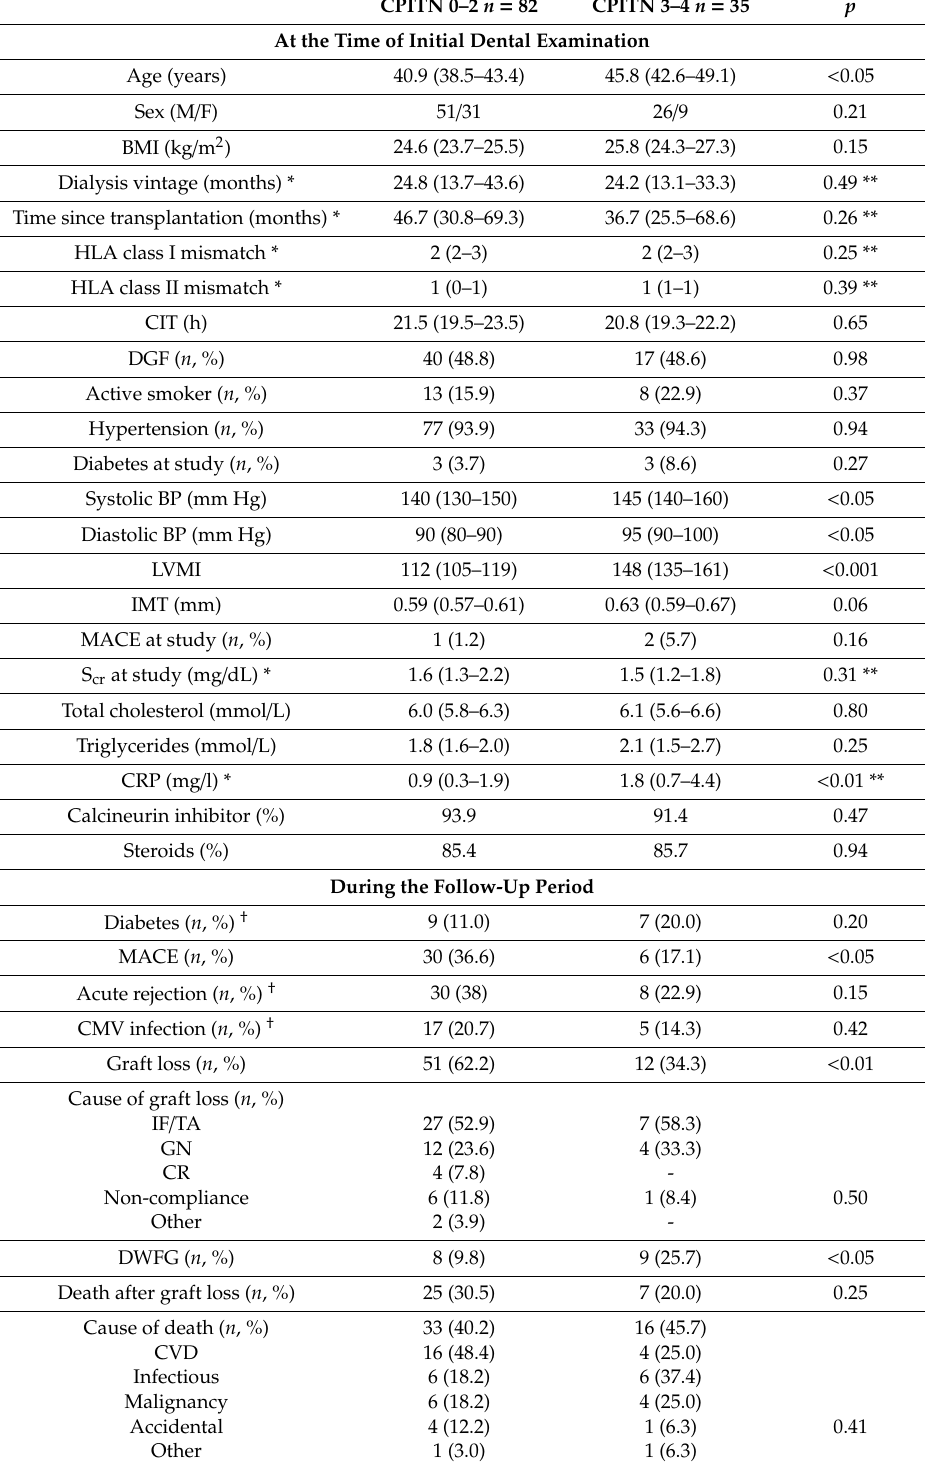
Table 1. Clinical characteristics of study patients divided into groups based on the initial CPITN